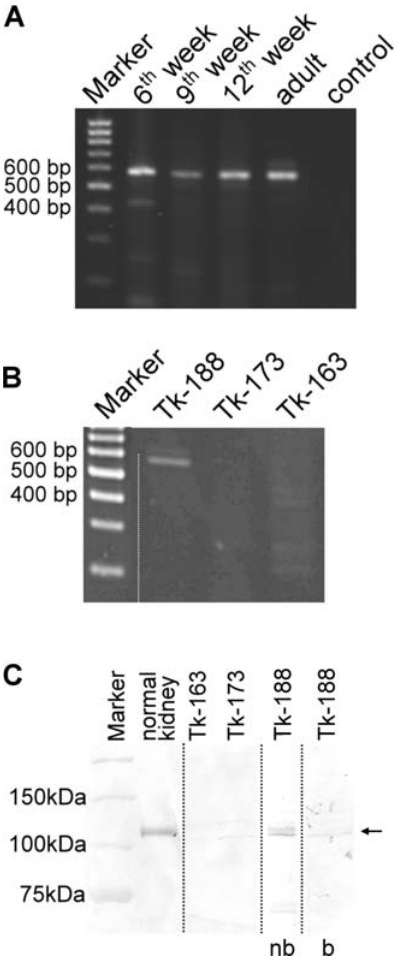
Figure 2. Cadherin-9 appears early in human kidney development and is expressed by a renal fibroblast cell line. (A) During human renal organogenesis, cadherin-9 mRNA is already detectable in the 6 th week of gestation. Positive signals were found throughout embryonic development and in the adult kidney. (B) RT-PCR screening of human renal cell lines detected cadherin-9 only in the renal fibroblast line TK 188 which was generated from a fibrotic kidney. Cadherin-9 was neither found in the fibroblast line TK 173 which originates from a normal kidney nor in the renal epithelial cell line TK 163. (C) These results were confirmed by Western blotting with a polyclonal anti-cadherin-9 antibody. The specificity of the anti-cadherin-9 antiserum was shown by pre-incubation of the antiserum with the peptide which the antibody was raised against (nb=non-blocked; b=blocked with